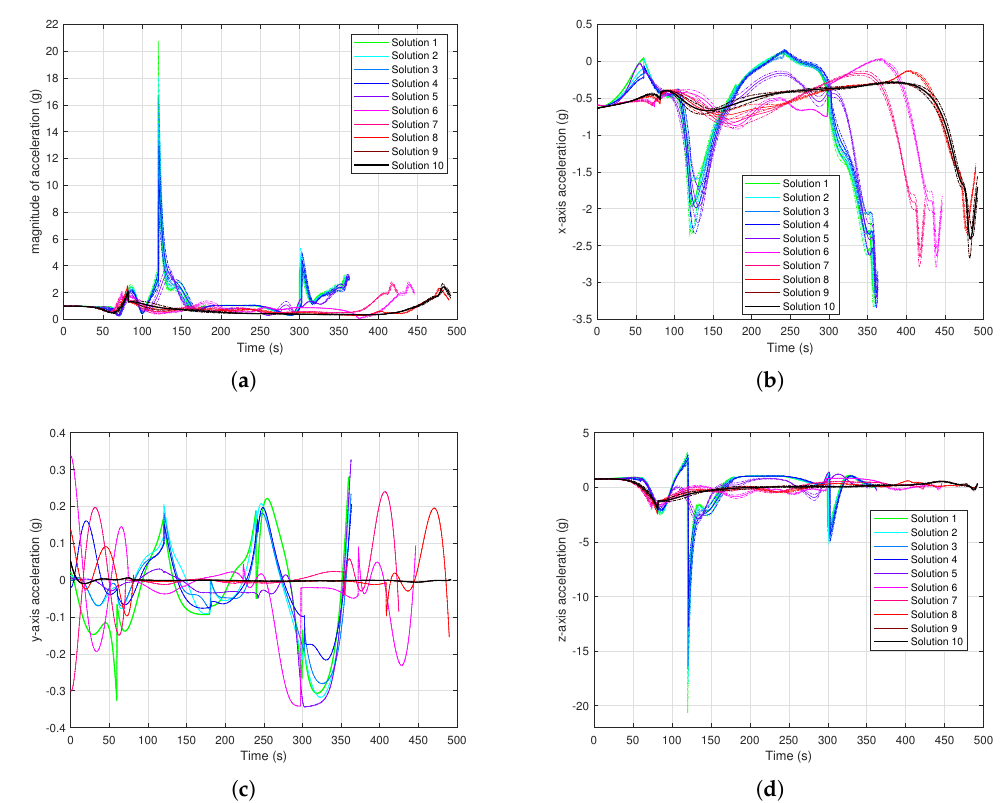
Figure 7. Magnitude and components (in vehicle body reference frame) of the induced accelerations, normalised against sea level gravity g = g 0 . ( a ) Magnitude of acceleration; ( b ) Component in x -axis; ( c ) Component in y -axis; ( d ) Component in z -axis.